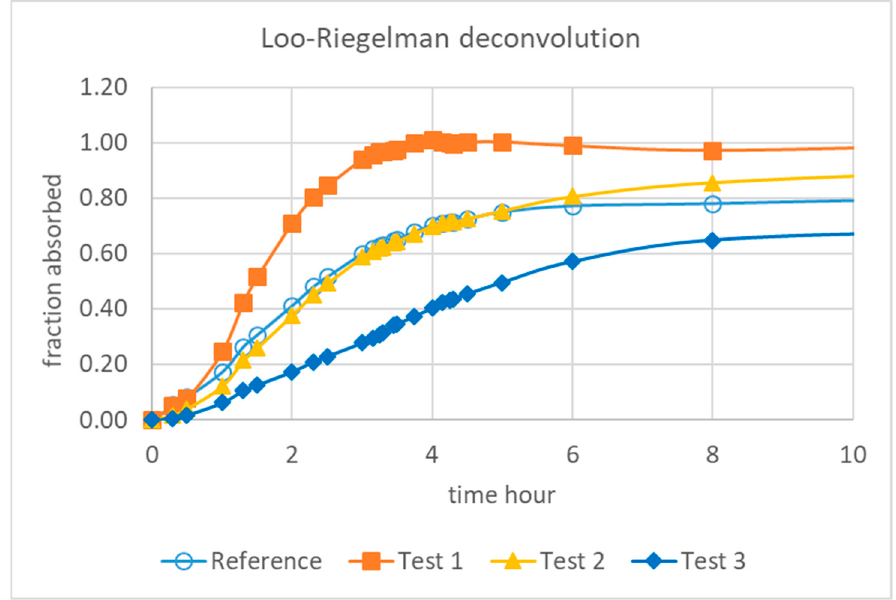
Figure 2. Fractions absorbed estimated with the Loo–Riegelman method.